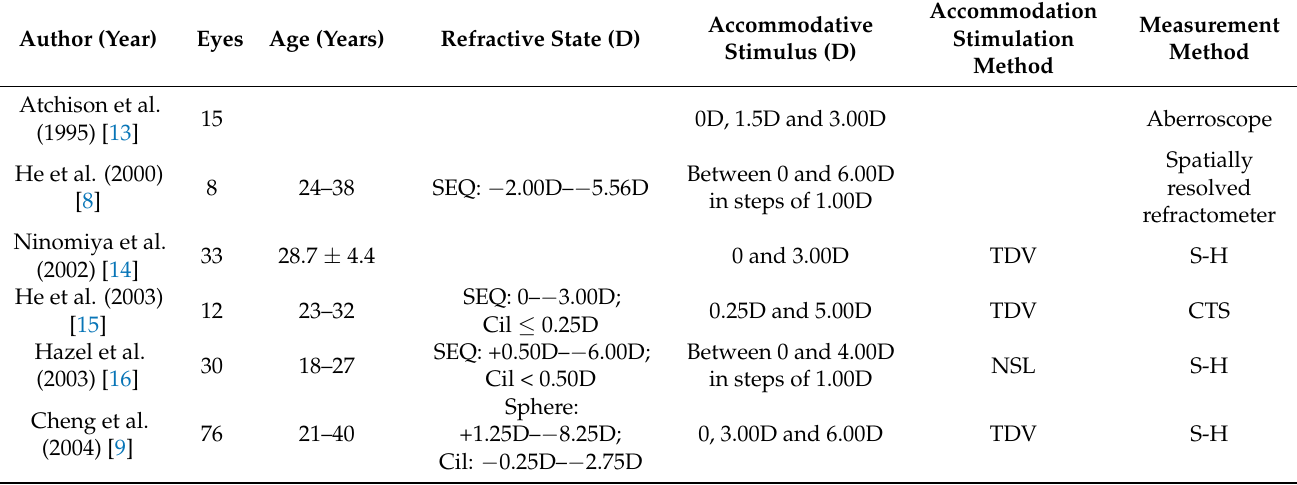
Table 1. Methodological characteristics of articles where wavefront aberrations were measured dur- ing accommodation.